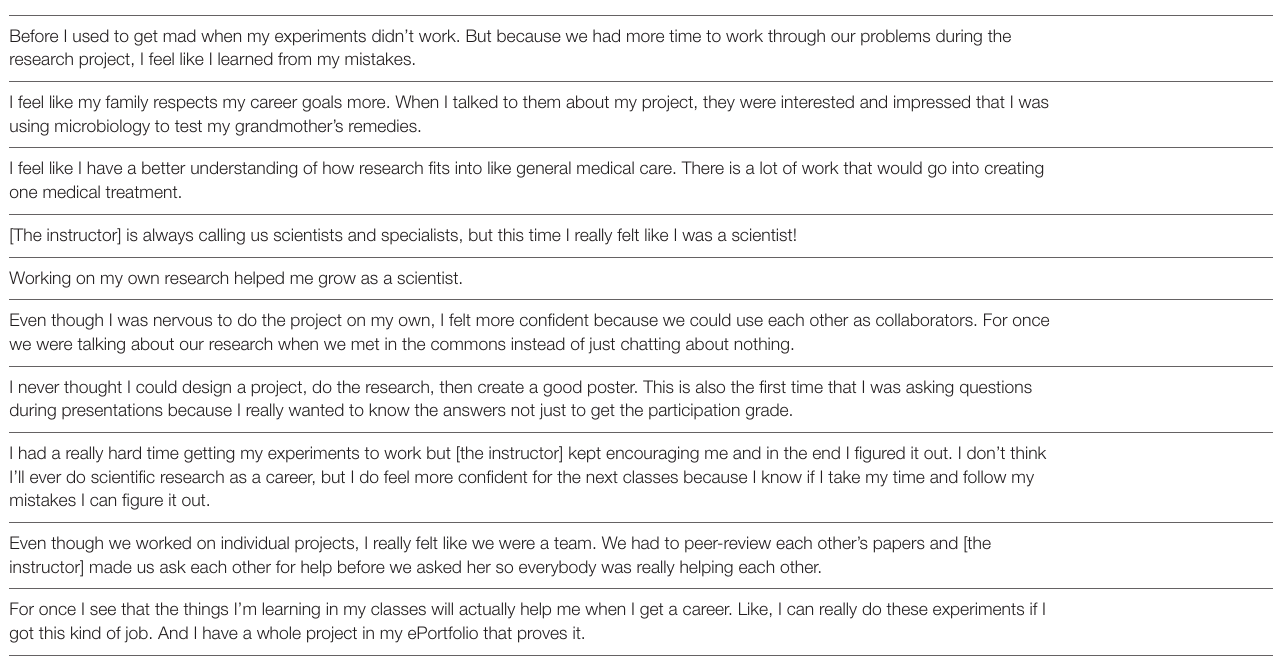
TABLE 6 | Student feedback from open-ended question: “Has the research project changed your perceptions of doing science?” Before I used to get mad when my experiments didn’t work. But because we had more time to work through our problems during the research project, I feel like I learned from my